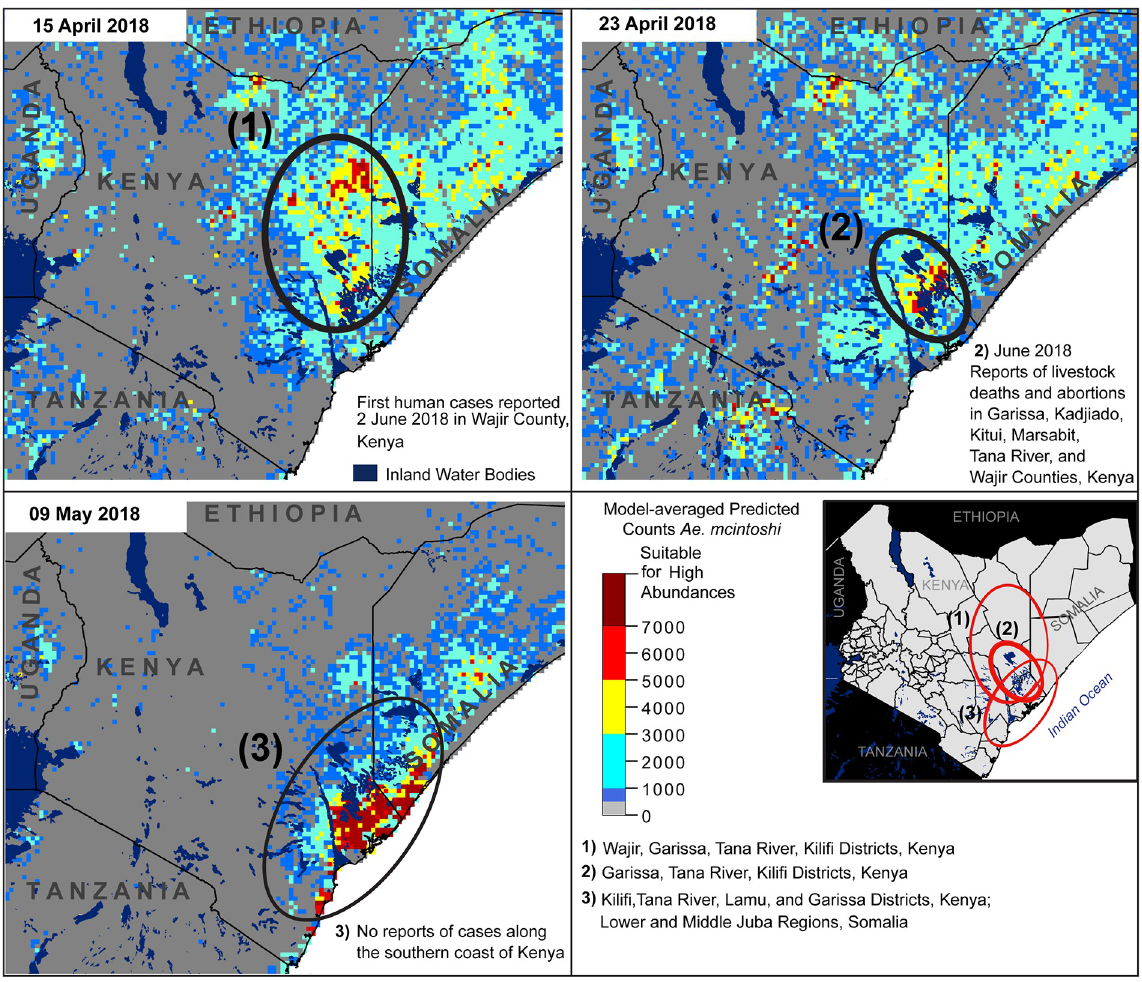
Fig 5. Predicted elevated abundances prior to the 2018 epizootic (heat maps) and locations of independently documented RVFV foci (numbered circles 1,2); areas with high predicted abundances, and no reports of RVFV activity (numbered circle 3). District boundaries fall inside circles in the lower right panel, with corresponding information provided below the panel